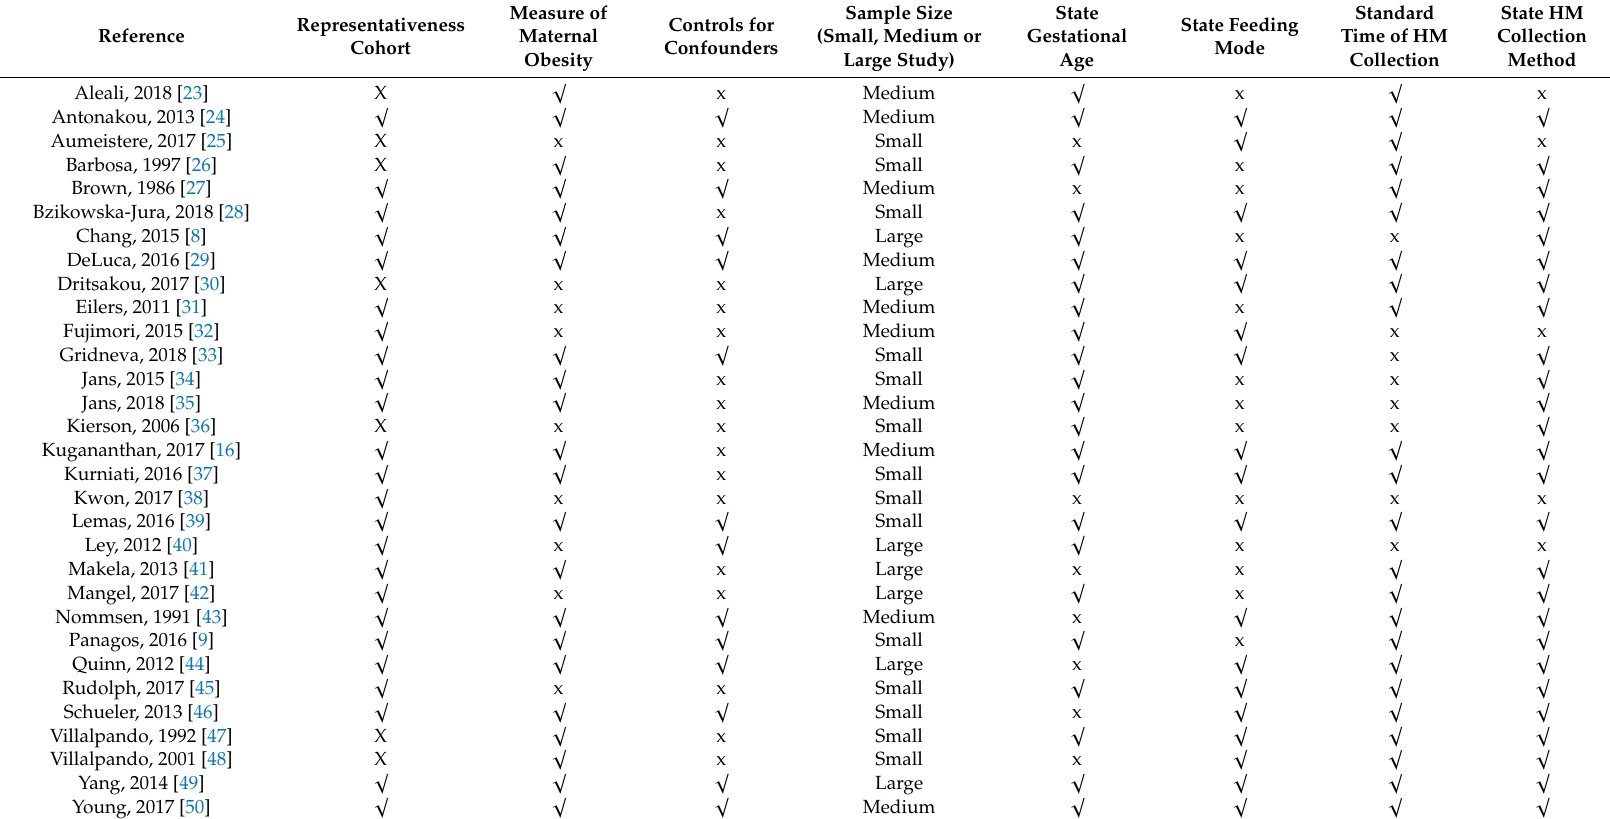
Table 4. Quality and reporting assessment for studies measuring macronutrient concentrations in human milk 1